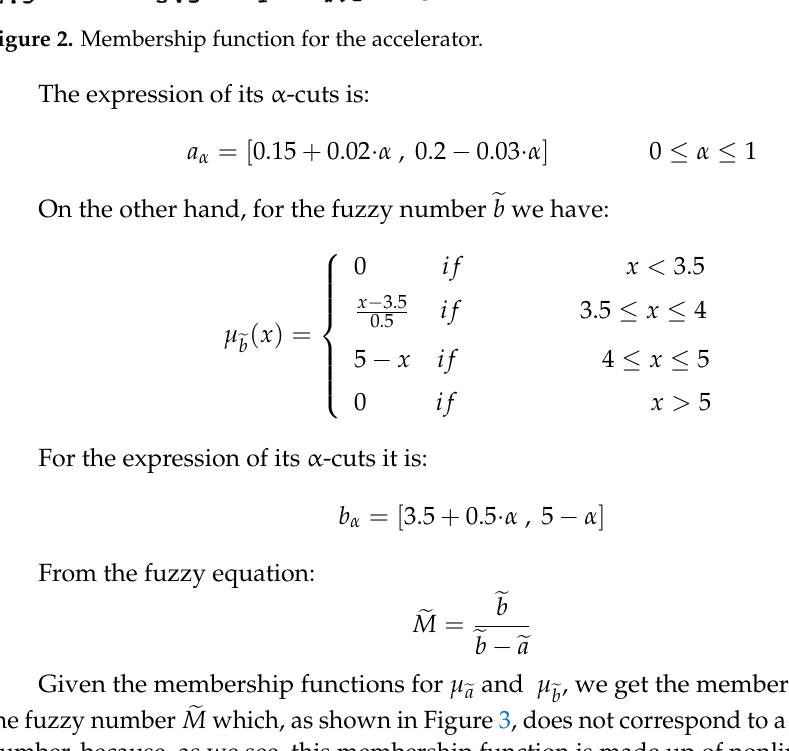
Figure 2. Membership function for the accelerator.